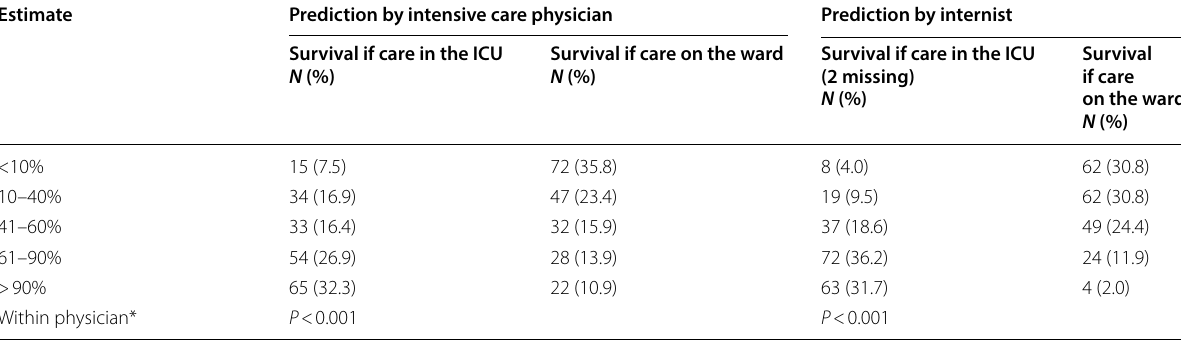
Table 2 Physicians’ estimated probabilities of survival for 201 patients evaluated for intensive